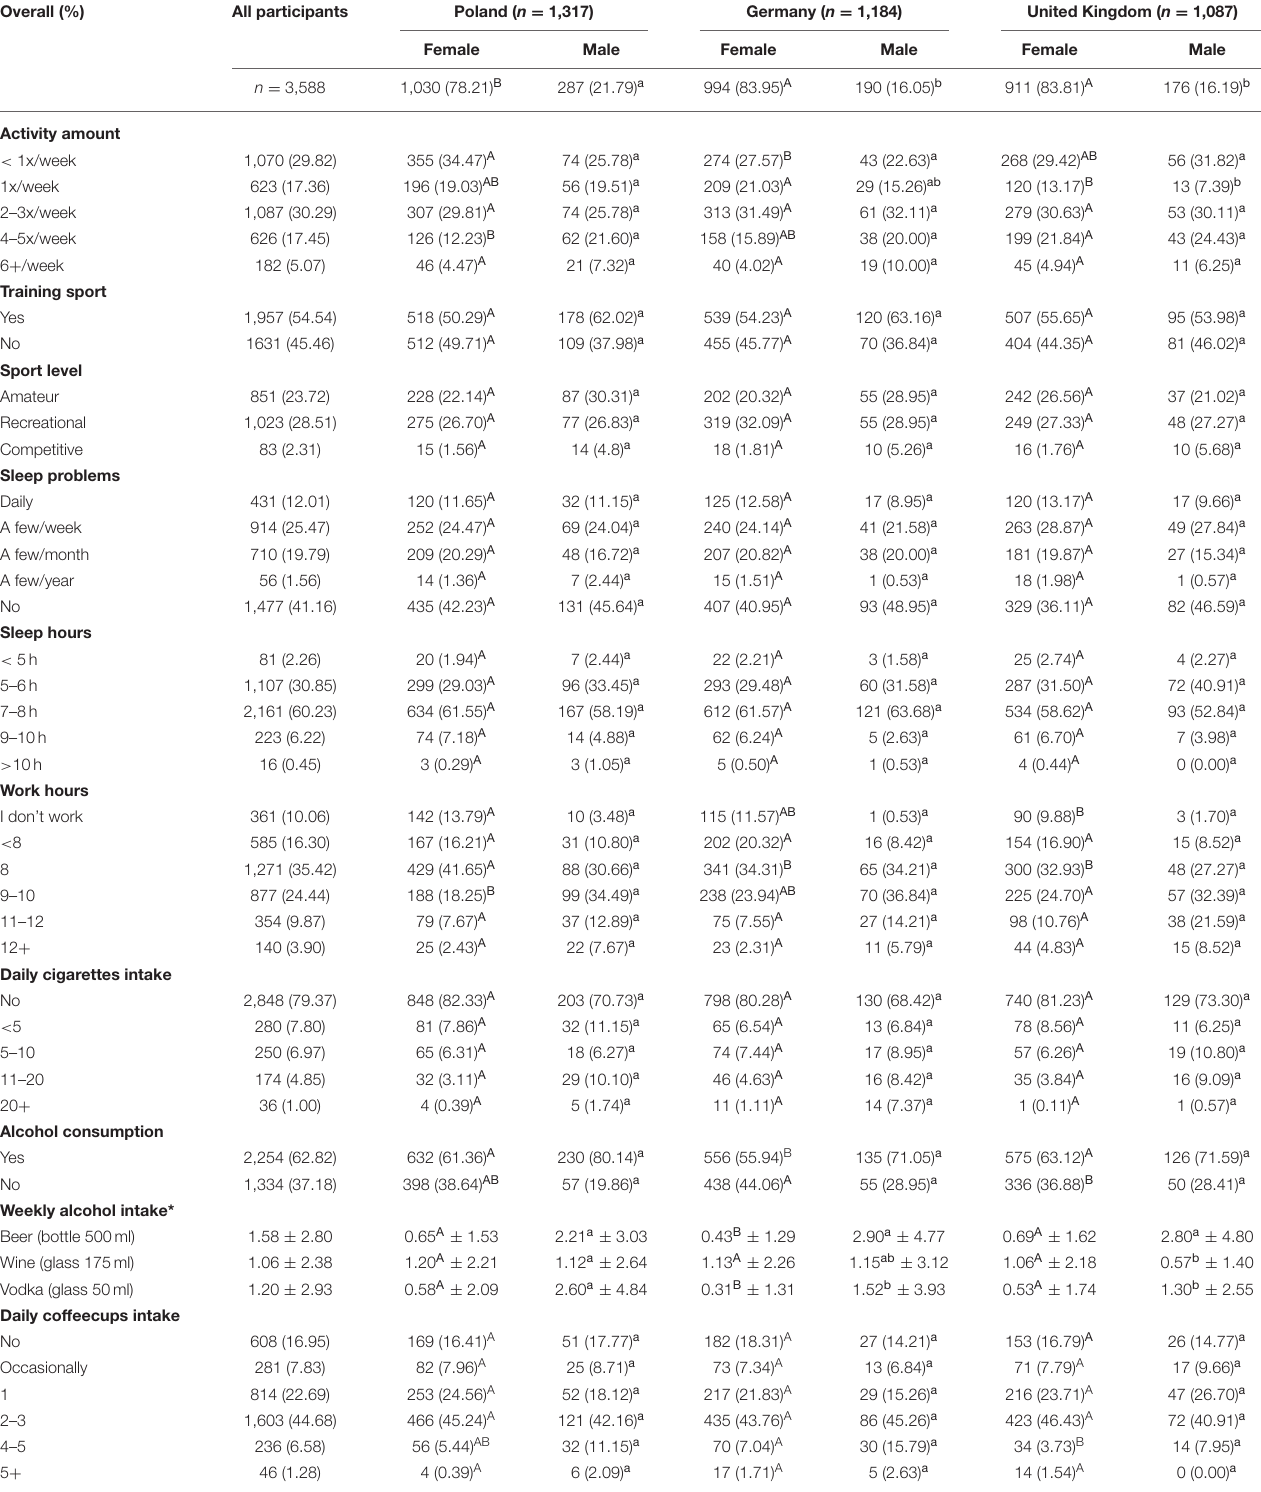
TABLE 2 | Lifestyle characteristics of DS